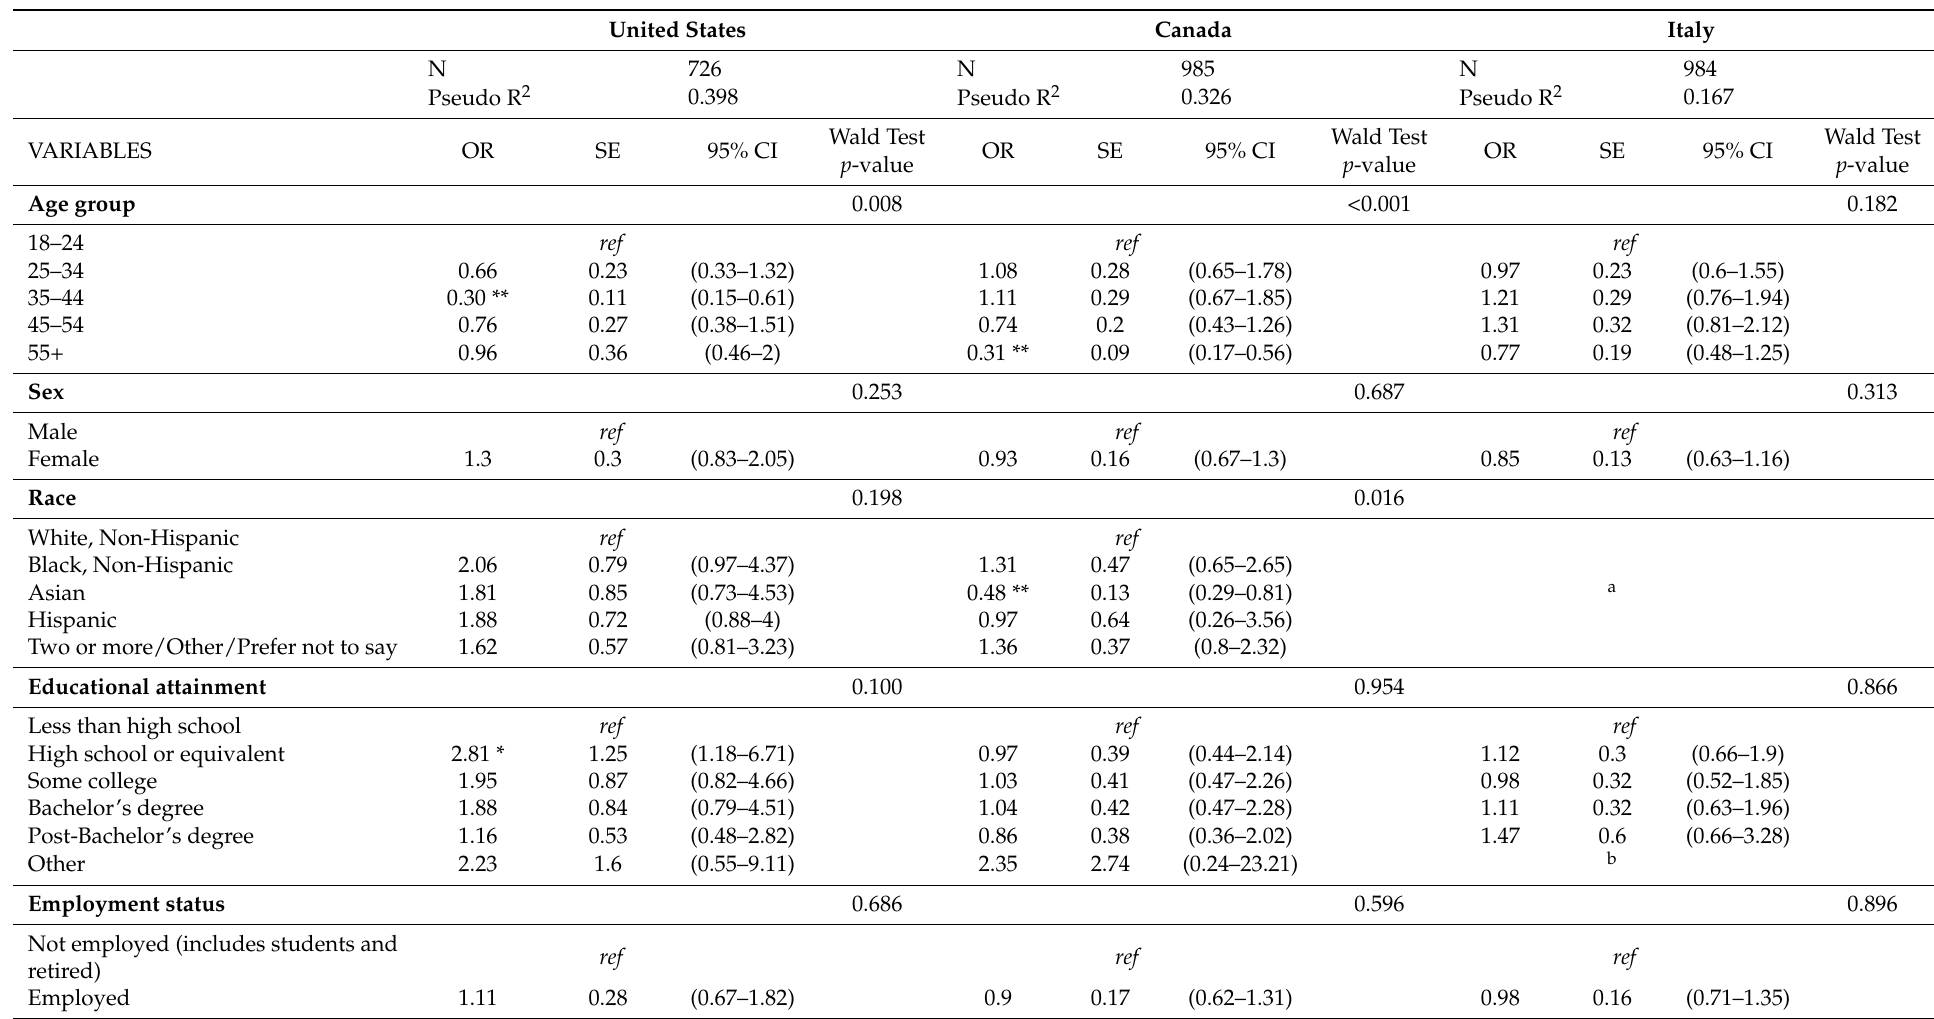
Table 3. Final Model (Model 3) in United States, Canada, and